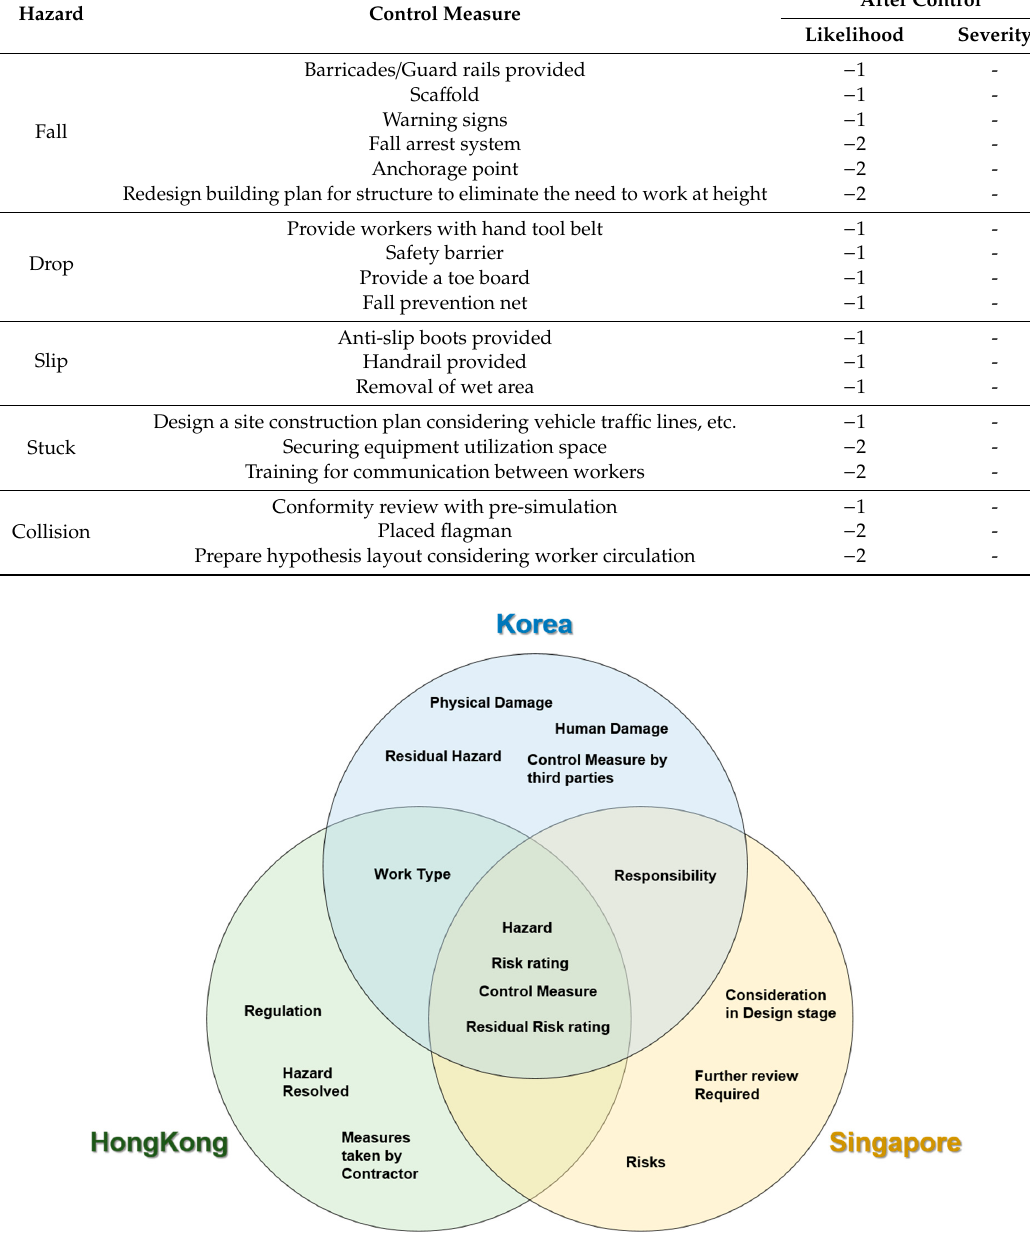
Figure 1. Design-for-safety review for different countries showing overlapping items.